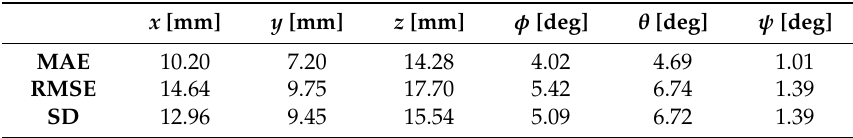
Table 1. Measured errors when the head was not moving. MAE: mean absolute error, RMSE: root mean square error, SD: standard deviation.